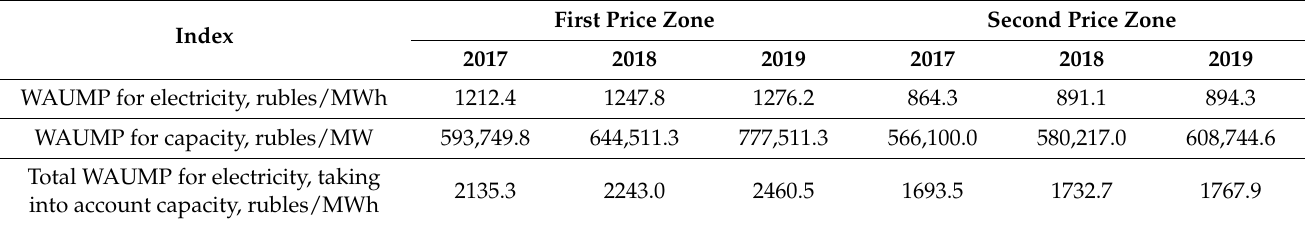
Table 3. Weighted average unregulated prices of the wholesale market in